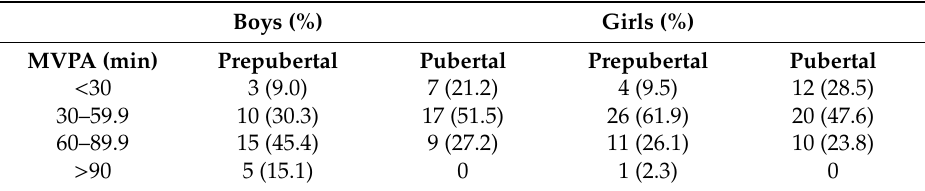
Table 3. Distribution in percentage of children by gender in prepubertal and pubertal periods, related with moderate-to-vigorous physical activity in the longitudinal sample ( n =